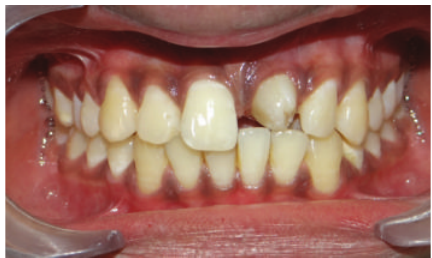
Figure 1: Intraoral clinical photograph depicting anomalous maxillary central incisor (frontal view).